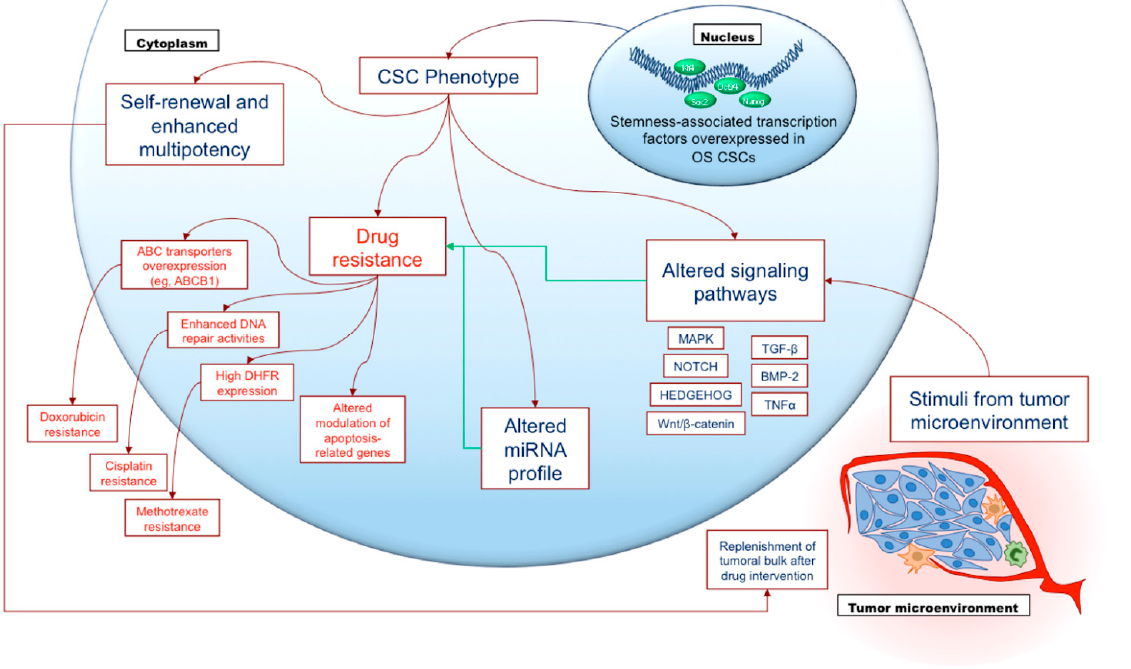
Figure 2. Involvement of osteosarcoma cancer stem cells in drug resistance. Osteosarcoma cancer stem cells (OS CSCs) represent a relatively small subpopulation in the tumoral bulk, characterized by high expression of stemness-related transcription factors (such as Sox2, Oct3/4, Nanog and Klf4). These characteristics promote self-renewal capability and enhanced multipotency, which enable OS CSCs to persist and to generate neoplastic cells as well, replenishing the tumoral bulk, i.e., following chemotherapy or surgical interventions. Nonetheless, the most critical feature of OS CSCs is enhanced drug resistance towards the main anti-neoplastic agents involved in high-grade osteosarcoma treatment, as a consequence of different mechanisms (the most relevant of which are shown in this Figure). Such chemoresistance may be enforced by aberrant miRNA expression and by alteration of different signaling pathways mainly induced by stimuli of the tumoral microenvironment.